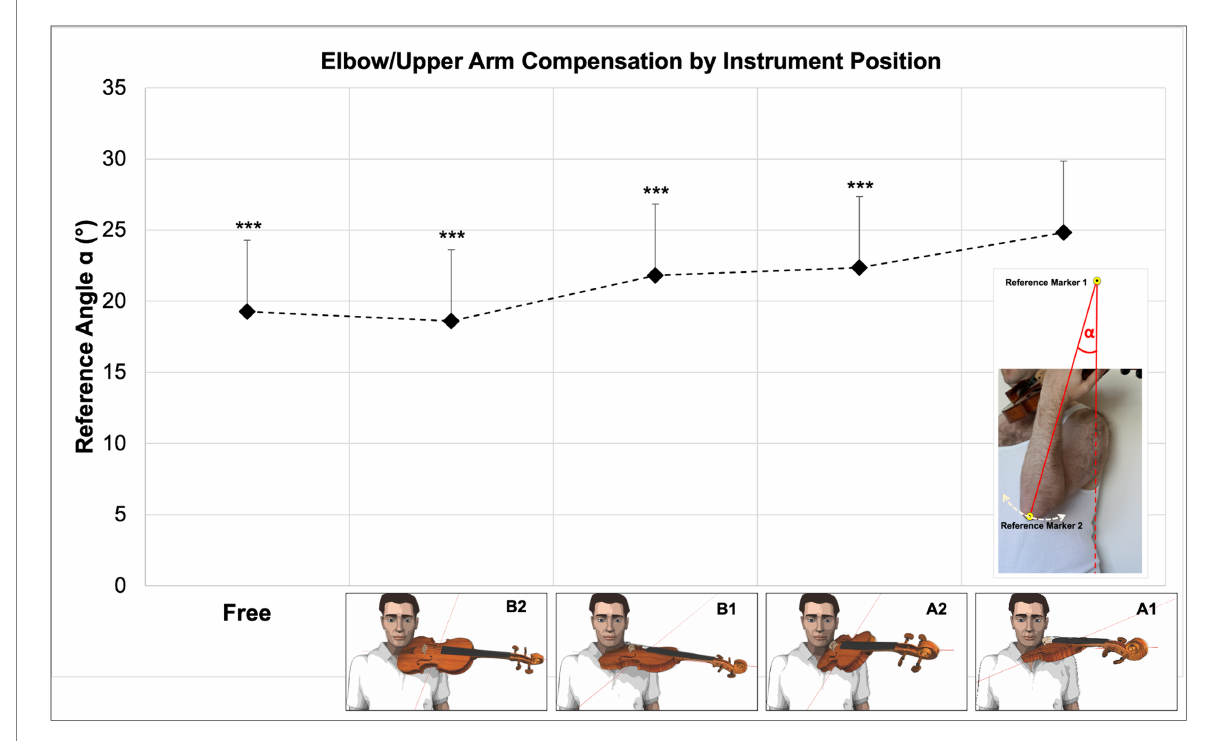
FIGURE 9 Degree of elbow/upper arm compensation movement expressed as Reference Angle α _ by instrument position. Differences between violin position A1 and all other instrument positions under test are highly significant ( p <